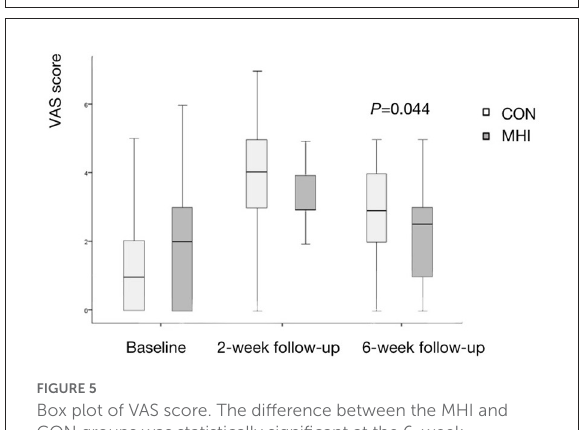
FIGURE5 Box plot of VAS score. The difference between the MHI and CON groups was statistically significant at the 6-week follow-up. Less pain in the MHI group was detected, which means better recovery.